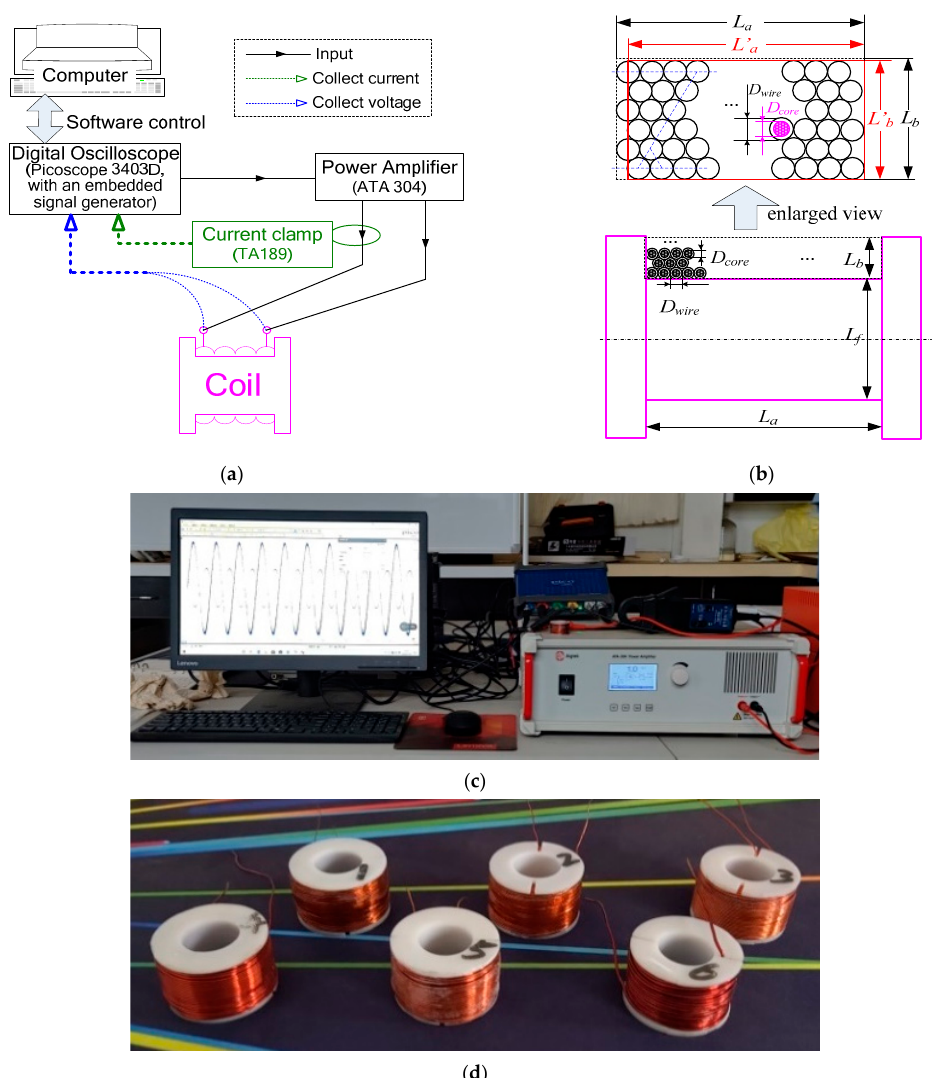
Figure 2. Experimental system and wound coils: ( a ) block diagram of the experimental system; ( b ) dimensioned sectional drawing of the coil, ( c ) photograph of the experimental system; ( d ) photograph of the coils.